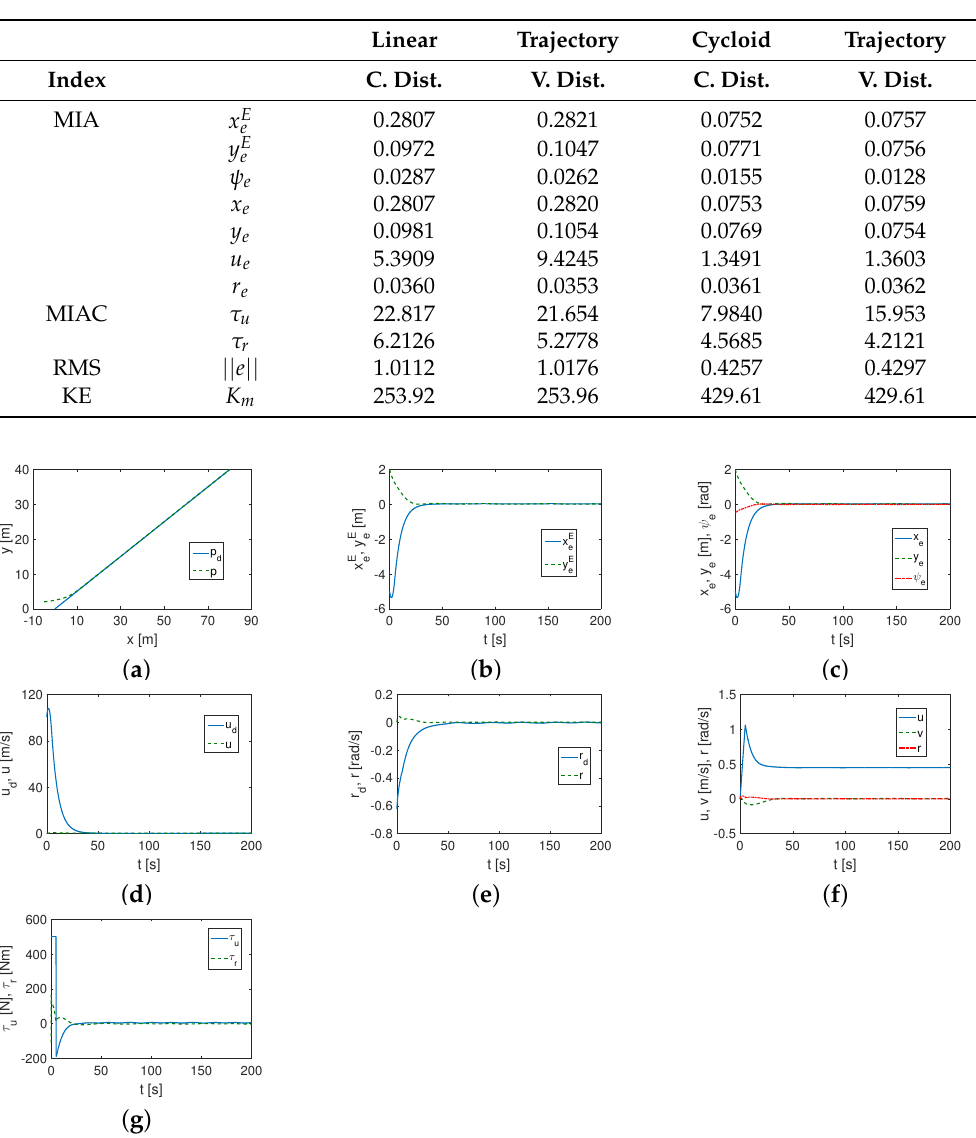
Figure 3. Simulation results for SIRENE—IQV controller and linear trajectory (variable disturbances): ( a ) desired and realized trajectory; ( b ) position errors (E-frame); ( c ) position errors (B-frame) and angu- lar error; ( d ) desired and realized velocity ( u d , u ); ( e ) desired and realized velocity ( r d , r ); ( f ) realized velocities; ( g ) applied force and